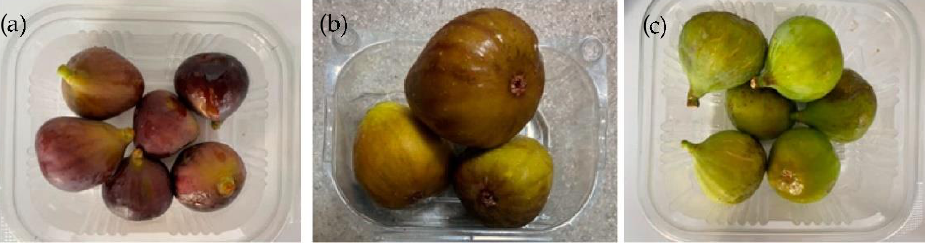
Figure 1. Fig varieties: ( a ) Șvinița Black, ( b ) Şviniţa Yellow and ( c ) Șvinița Green.